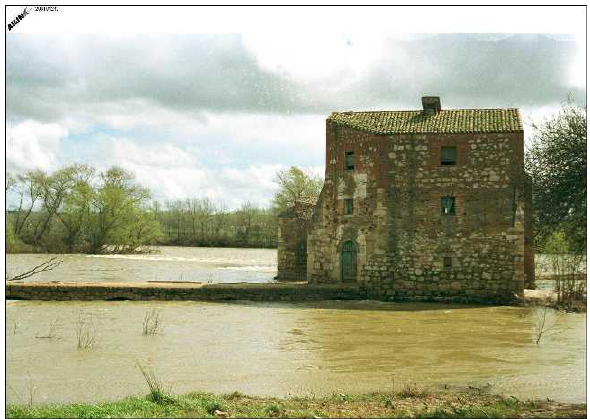
Figure 4: Frontal view of Pisones flour fabric